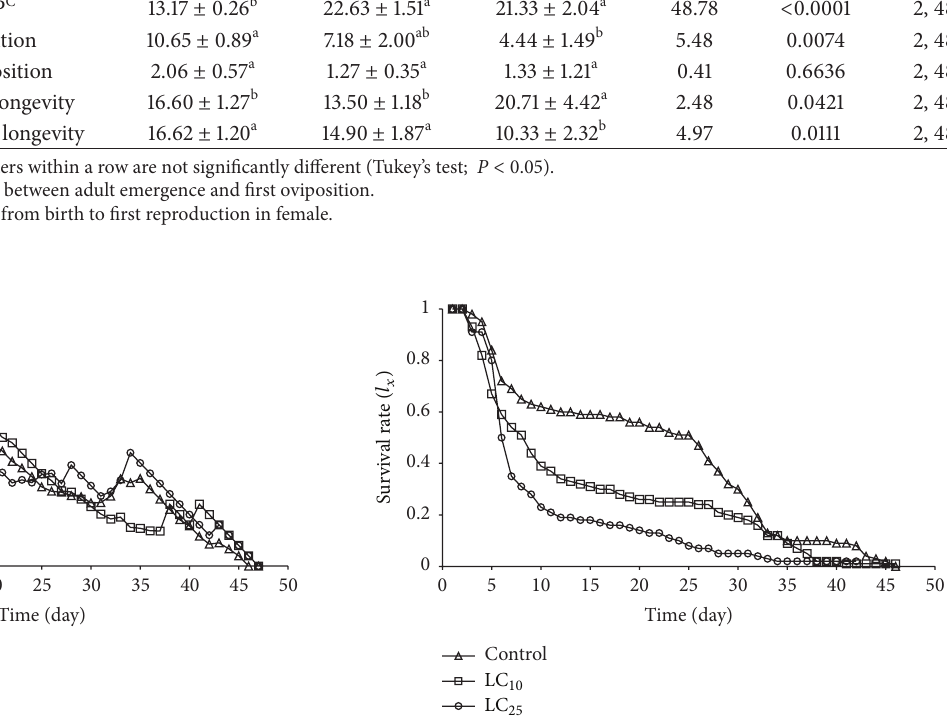
Figure2:Thelifeexpectancy( 𝑒 𝑥 )of P. xylostella aftertreatmentwith Figure 3: The survival rate ( 𝑙 𝑥 ) of P. xylostella treated with sublethal doses of